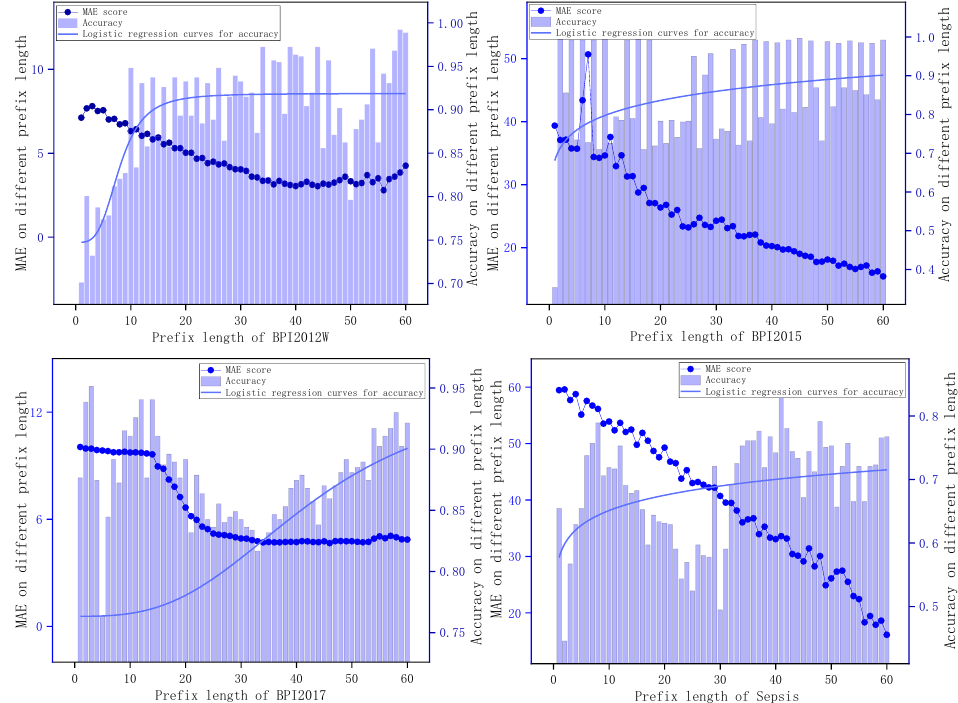
Figure 3. Influence of Prefix Length on Accuracy and MAE of HiP-Transformer.